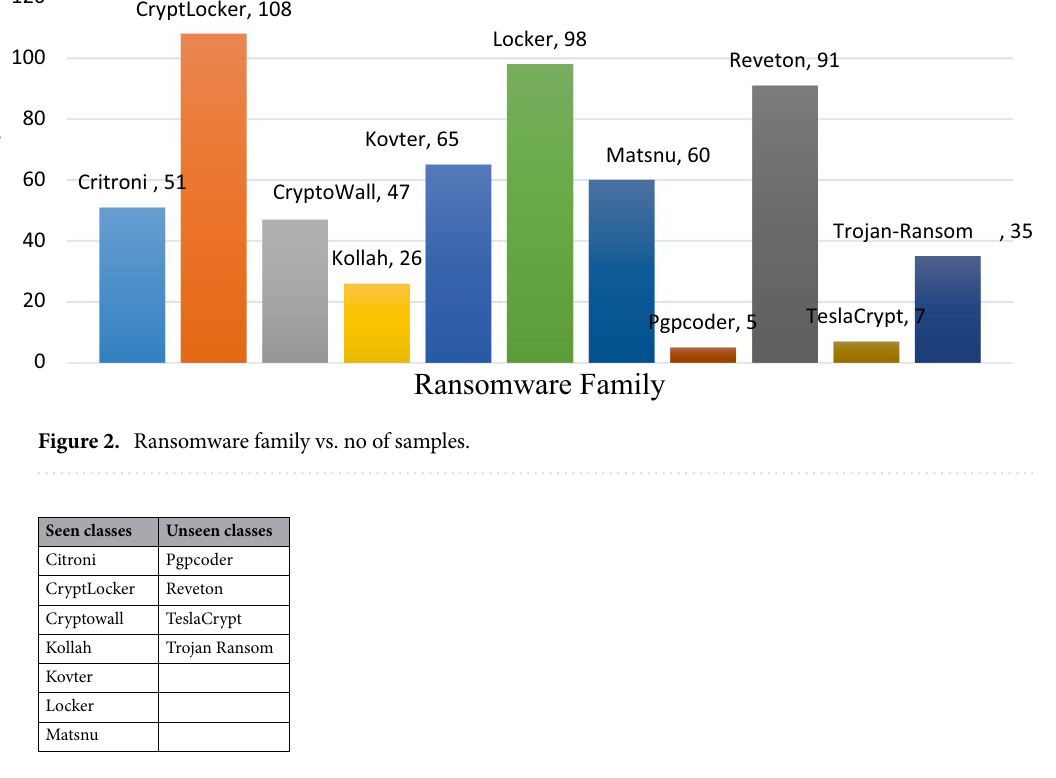
Table 1. Train test split of ransomware